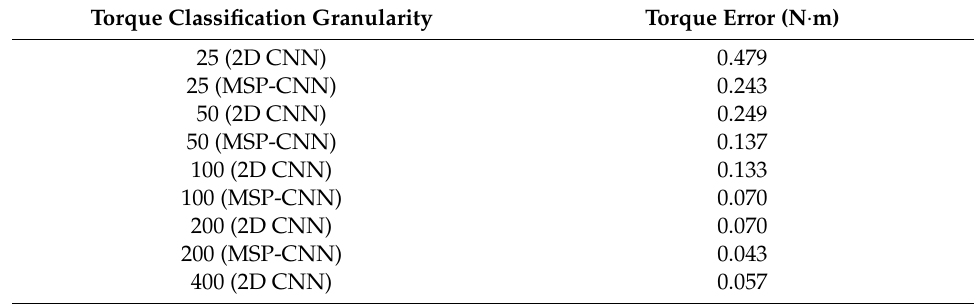
Table 4. Torque estimation errors by 2D CNN and MSP-CNN using the same classification granularity. Torque Classification Granularity